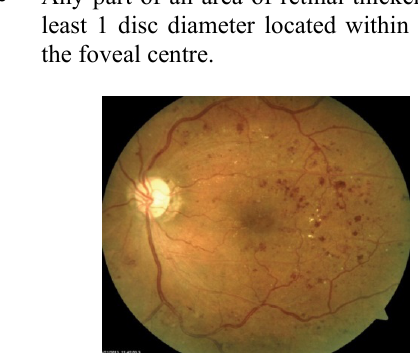
Figure 1. Diabetic Retinopathy